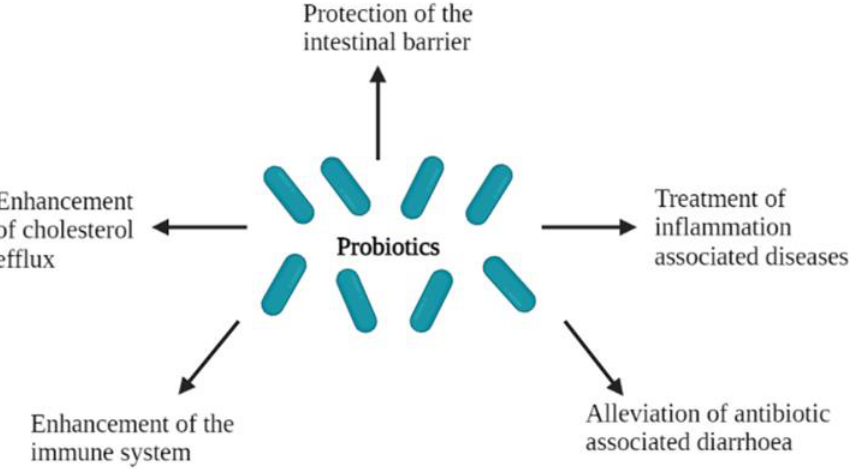
Figure 3. Health effects of probiotics in the host.